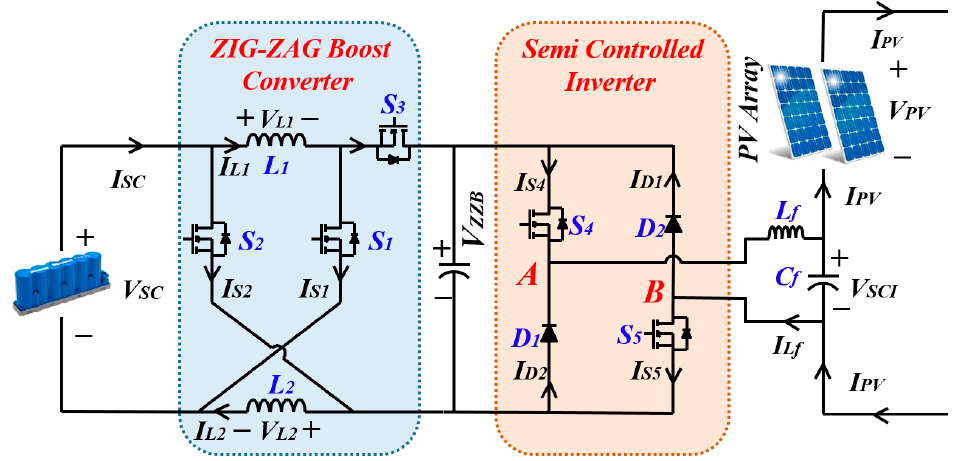
Figure 3. The SC-PPS consists of ZZB and SCI in a back-to-back fashion. For the SC Buck-Boost stage, the Zig-Zag Boost (ZZB) bidirectional converter is used as a better alternative over the conventional Boost converter due to its better efficiency vs.